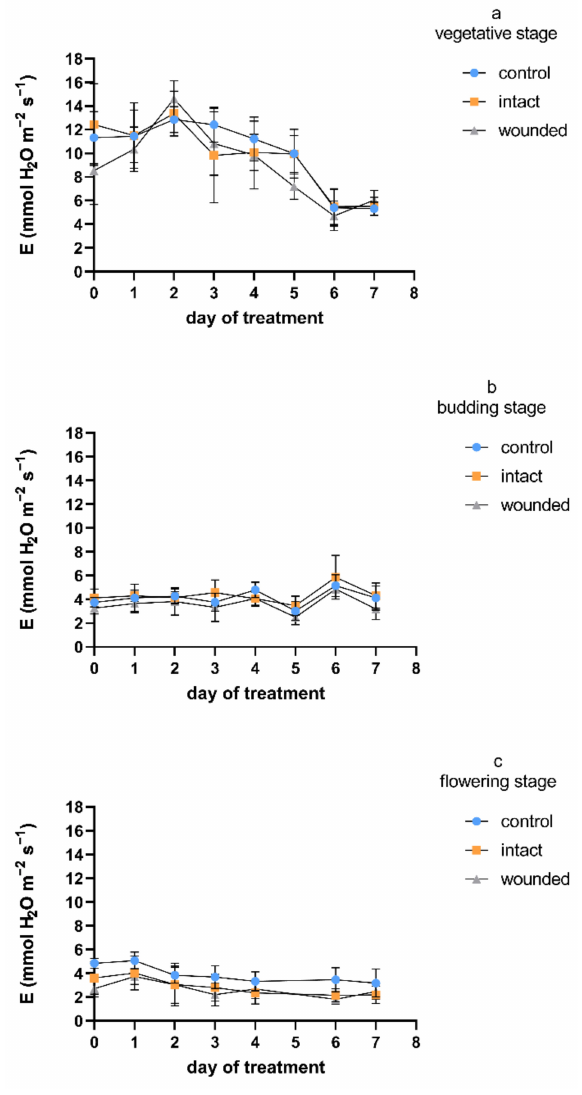
Figure 3. Transpiration rate of Ocimum basilicum var. minimum L. versus leaf wounding imposed at the ( a ) vegetative, ( b ) budding, or ( c ) flowering stage. Data are means ( n = 7) ± standard deviation